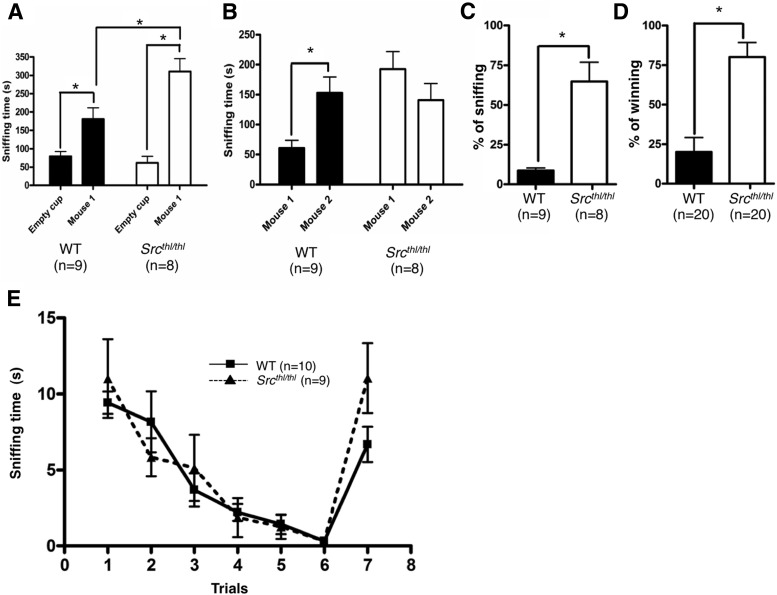
Social approach behaviors are increased and social recognition is impaired in Srcthl/thl mice. A, Srcthl/thl mice spent more time sniffing a social cage versus a nonsocial cage (n = 9 WT males, n = 8 Srcthl/thl males). B, During the second phase of the test to measure social recognition, Srcthl/thl mice did not show a preference for a novel mouse versus a familiar mouse from the first phase (n = 9 WT males, n = 8 Srcthl/thl males). *p < 0.05, compared to the chamber with empty cage, between genotypes and within genotypes, respectively. C, In a direct social interaction test, Srcthl/thl mice showed an increased frequency of interactions with a stranger mouse. Data are presented as mean ± SEM (n = 9 WT males, n = 8 Srcthl/thl males). *p < 0.05, between genotypes. D, Srcthl/thl mice showed social dominance over their WT littermates in a tube test (n = 20 WT males, n = 20 Srcthl/thl males). *p < 0.05, between genotypes. E, Srcthl/thl mice were able to habituate to a smell over time and dishabituate toward a novel smell, demonstrating intact olfaction (n = 10 WT (5 males, 5 females), n = 9 Srcthl/thl (5 males, 4 females)). Data are presented as mean ± SEM.